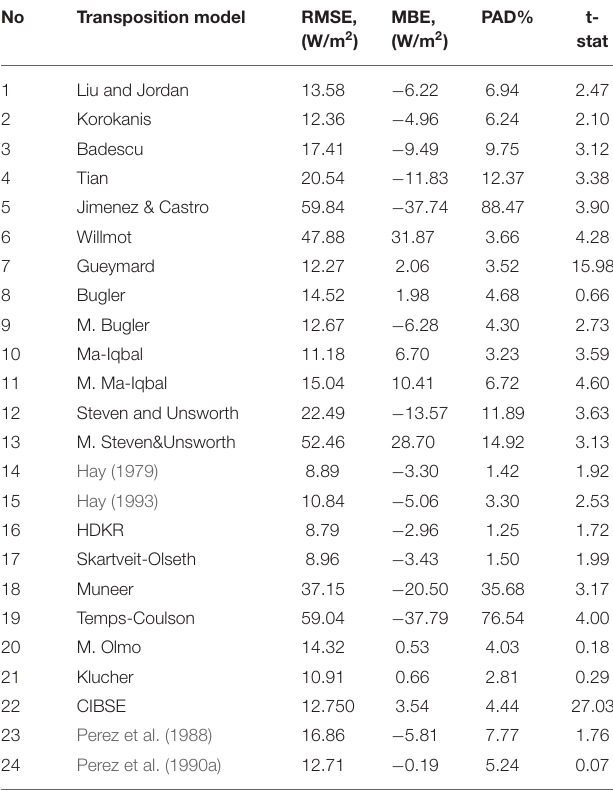
TABLE 2 | Results of the transposition models, for Hebron city for a tilted angle of 30 ◦ south facing. No Transposition